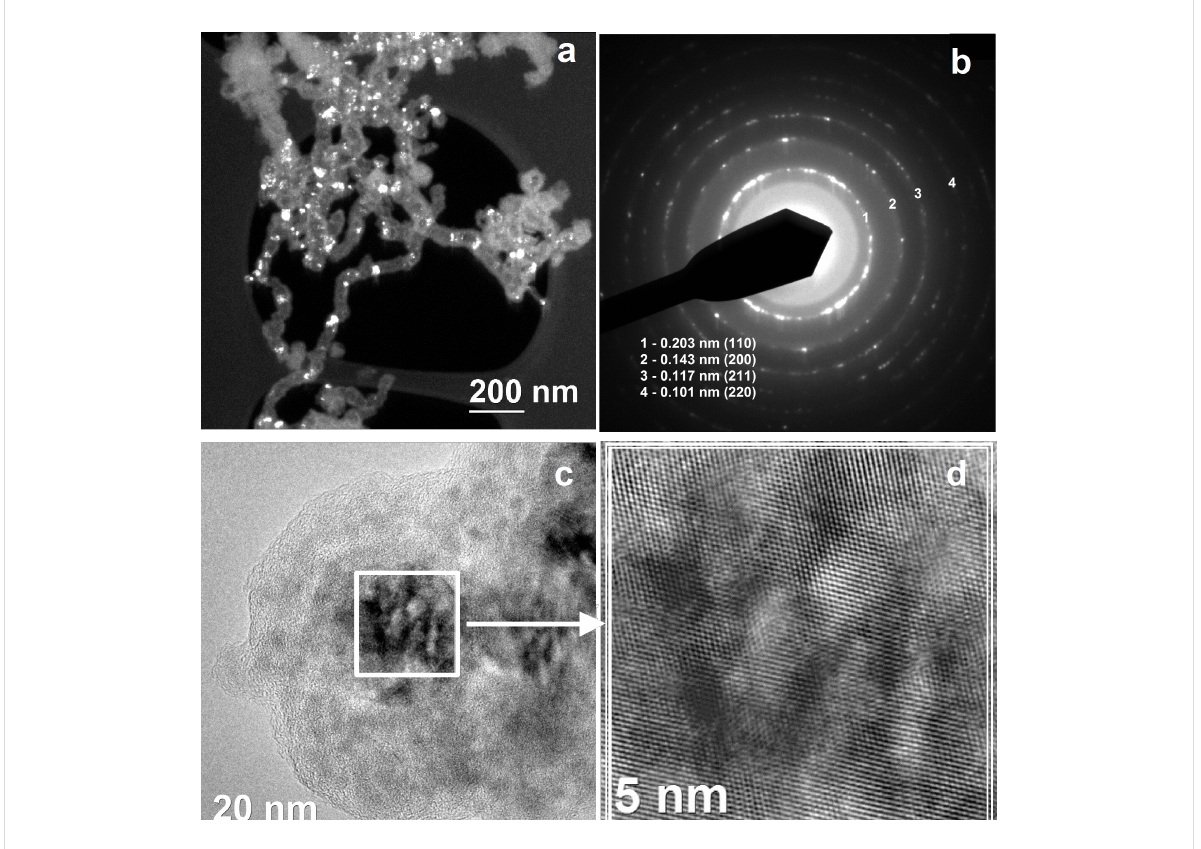
Figure 2: TEM images of 4-nitrophenyl-coated ZVI NPs (a) darkfield image of the NP morphology, (b) FFT image, (c) high-resolution transmission electron (HRTEM) micrograph showing a nearly spherical, crystalline NP with an organic layer coating and (d) HRTEM with high magnification.